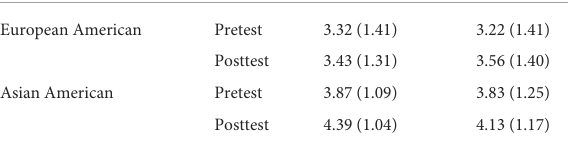
TABLE 2 Behavioral outcomes by message frame and audience